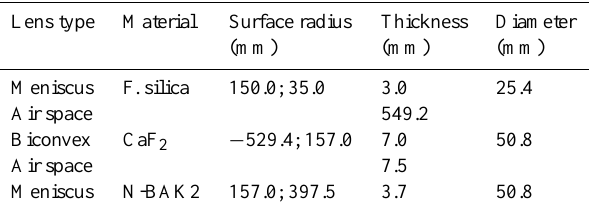
Table 5. Beam expander of Polly. The first lens is from stock (Thor- labs, LF4938). The 2inch lens pair is